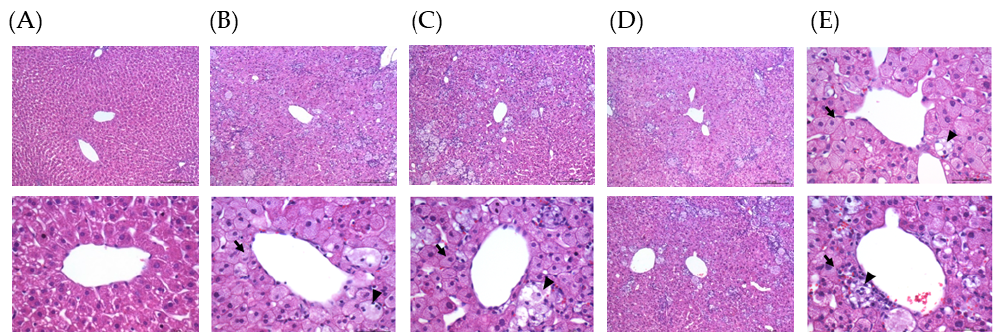
Figure 3. Hepatic histopathology of hamsters fed an HFD after a melatonin (MEL) intervention for eight weeks (200 × magnification): ( A ) Control with a regular diet, ( B ) HFD without MEL), ( C ) HFD with 10 mg/kg MEL, ( D ) HFD with 20 mg/kg MEL, and ( E ) HFD with 50 mg/kg MEL. Microvesicular fatty changes (arrow) were observed. Slight Kupffer cell hyperplasia was observed (arrowheads).